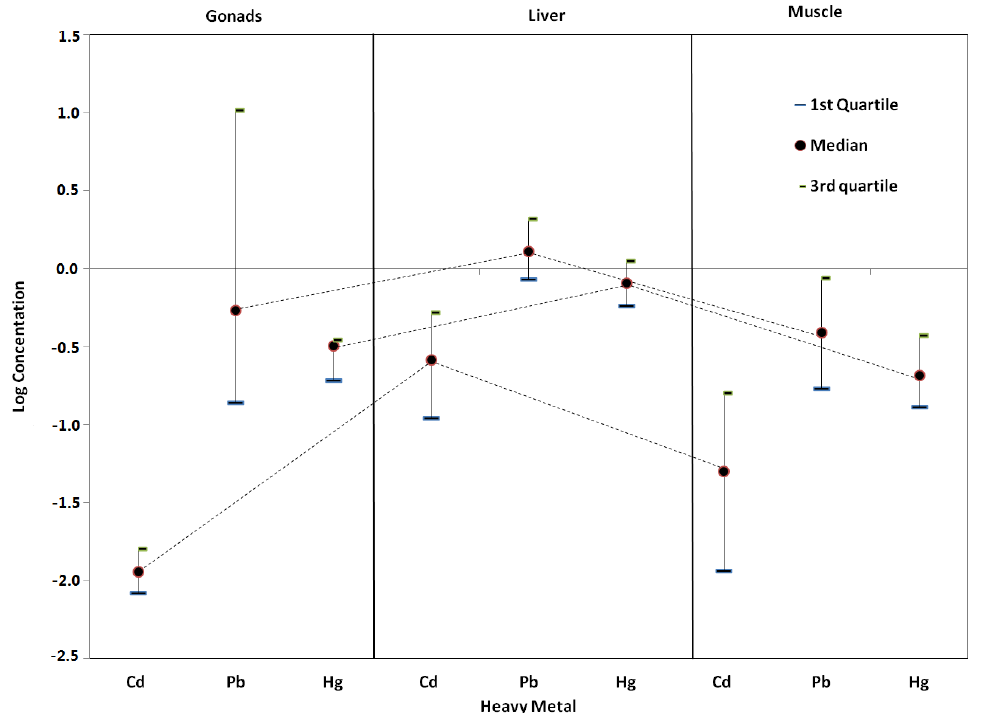
Figure 3. Median, 1st and 3rd quartiles of log-scale concentration of Cd, Pb and Hg per type of